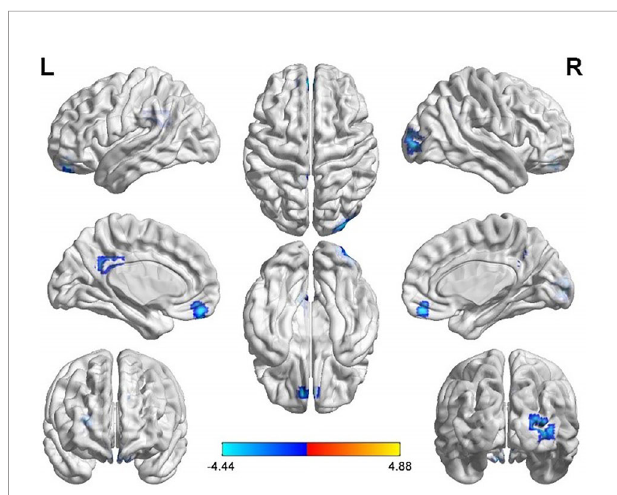
FIGURE 1 | Signi fi cantly increased (red) and decreased (blue) ALFF values in women with polycystic ovary syndrome compared with controls (the peak level threshold p = 0.001; cluster level FDR-corrected, p < 0.05). The color bar represents the t-value of the two-sample t-test between the two